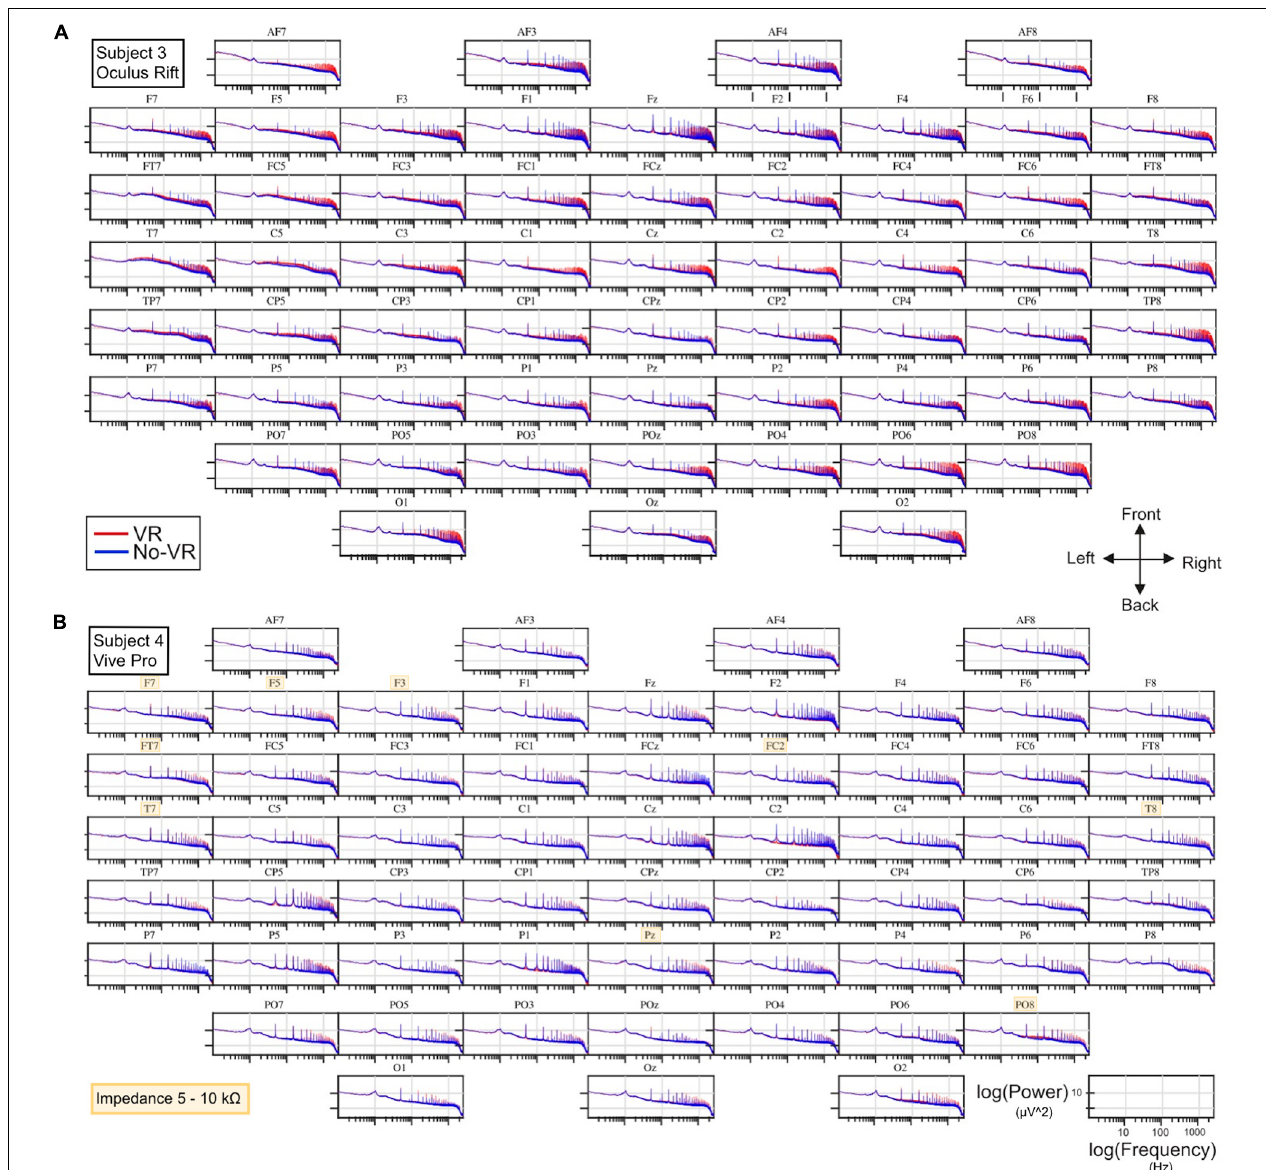
FIGURE 3 | Topographical overview for spectral power ( µ v 2 ) over frequency (Hz) at all electrode positions during eyes-closed trials for (A) subject 3 (using the Oculus Rift HMD) and (B) subject 4 (using the Vive Pro HMD). The orientation of the electrodes is indicated on a directional cross, all axes are logarithmic. Blue and red curves represent the signal acquired during absence (No-VR) and presence (VR) of an HMD, respectively. In (B) , electrodes with an impedance > 5k (cid:127) are highlighted in yellow. The slope for all displayed curves approx. follows a 1/f trend. In frequencies below 100 Hz, the spectra matched closely over both conditions, whereas higher frequencies in (A) displayed additional sharp peaks. These peaks were absent or of lower amplitude at the equivalent frequencies in (B) . For Topographical overview of all subjects, refer to Supplementary Figures 2–9